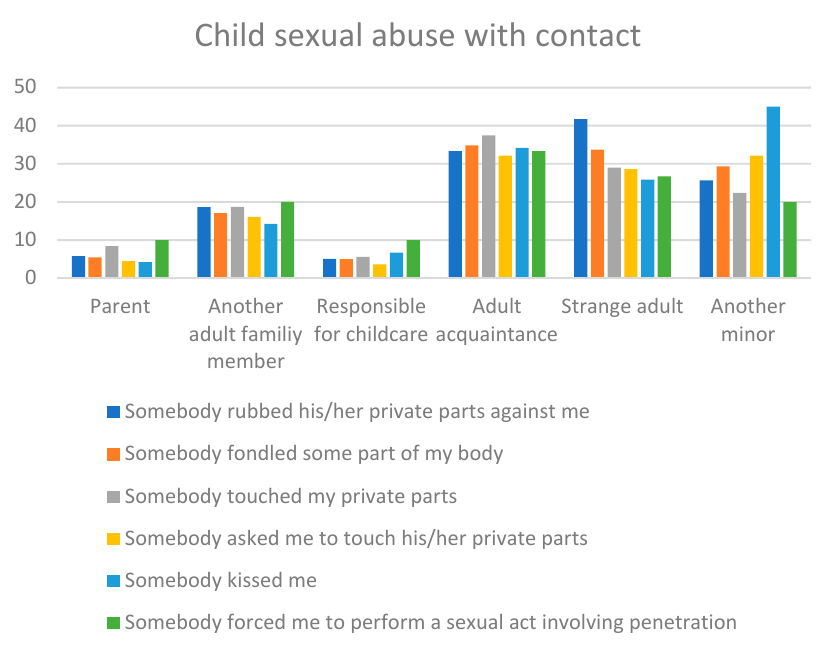
Figure 2. Perpetrator as a function of the type of CSA with contact.